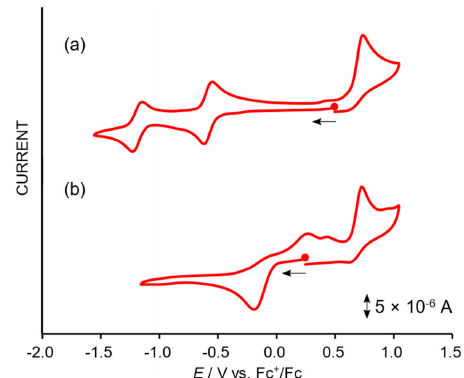
Figure 7. Cyclic voltammograms of [MnBr(CO) 3 (dpq)] in the absence and presence of H + in CH 3 CN